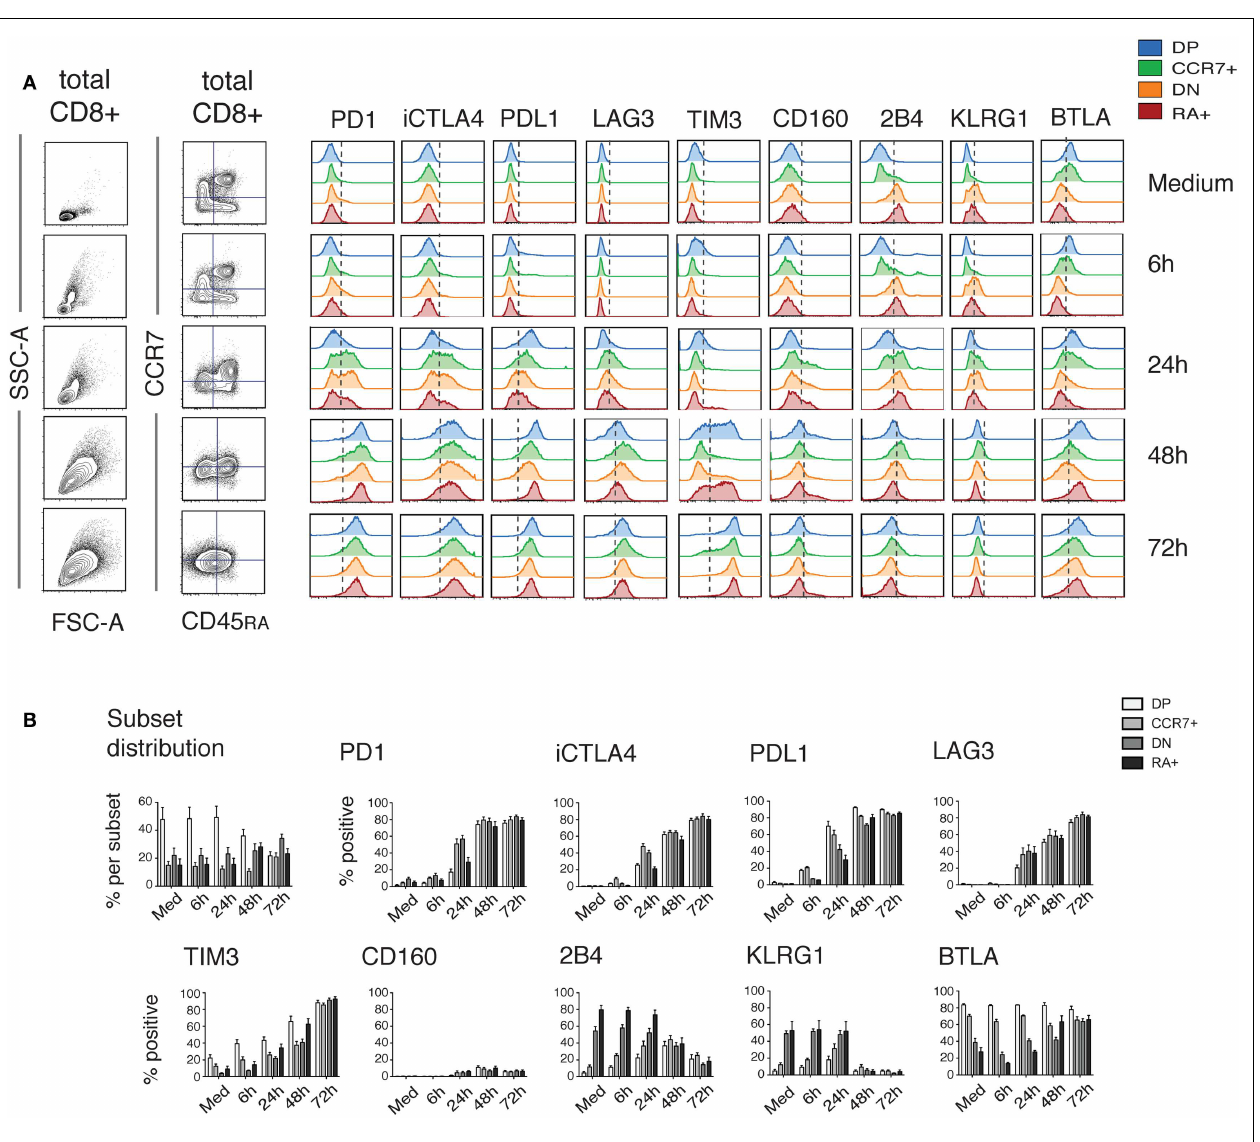
FIGURE 3 | Dynamics of iR expression over 3days of stimulation . PBMC from healthy donors were stimulated for different time-periods with anti-CD3 and anti-CD28 antibodies. CD8T cells were analyzed similarly to Figure 1 for the various iRs. (A) . CCR7 versus CD45RA-based differentiation plot and FSC versus SSC plot of total CD8T cells, as well as off-set overlay histograms for each iR comparing the various subsets as indicated. In order to analyze iRs